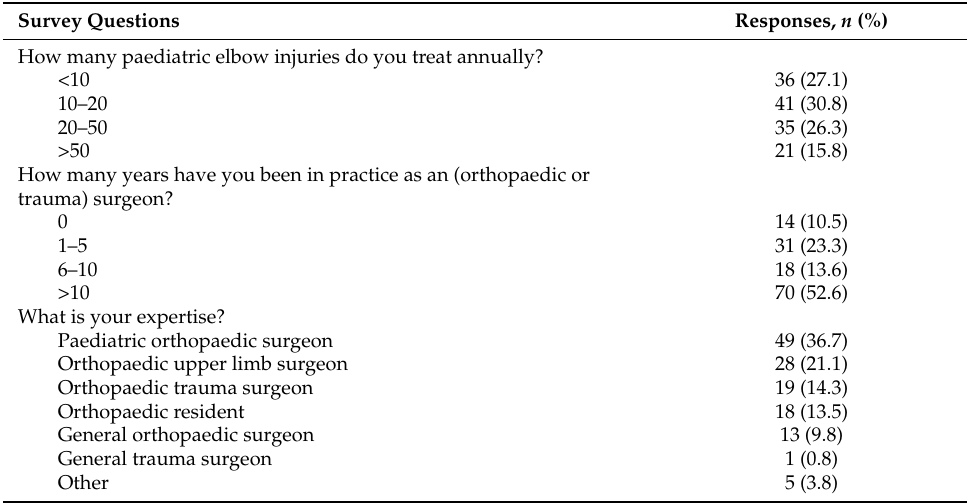
Table 1. Respondent characteristics ( n = 133).